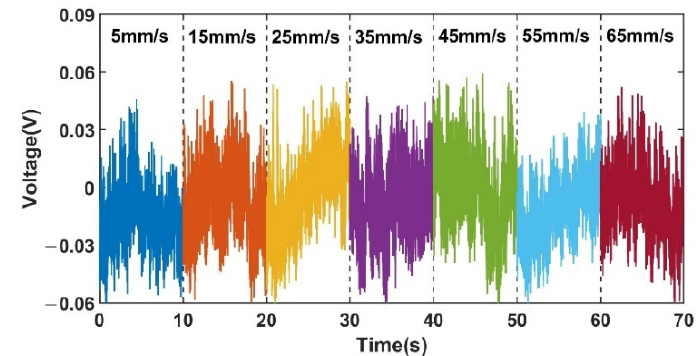
Figure 9. Noise signals at different velocities under no load.